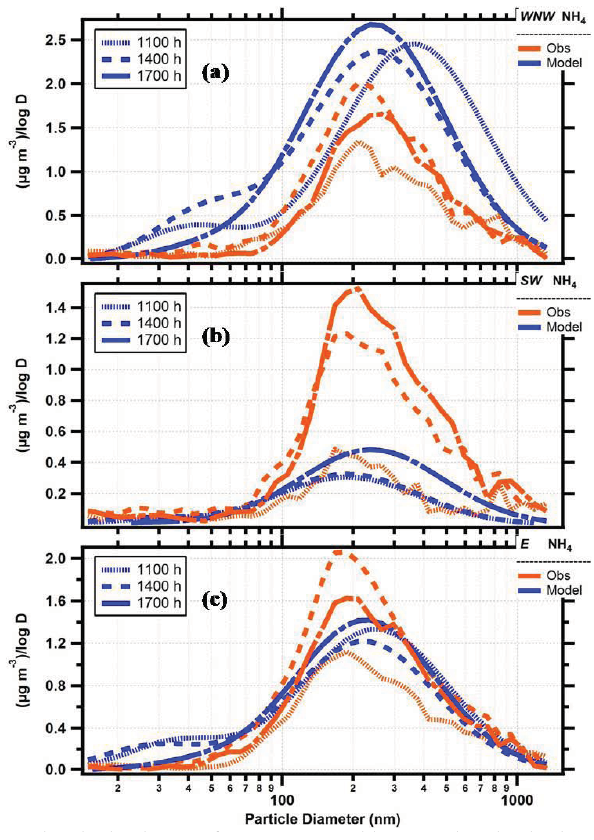
Figure 8. The size distributions are for the same conditions described in Fig. 6, but for ammonium. Fig. 8. The size distributions are for the same conditions described in Fig. 5, but for